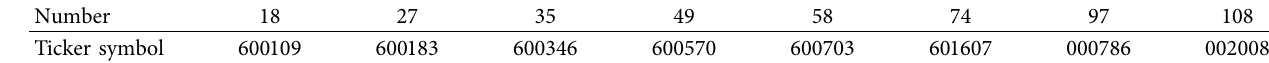
Table 2: List of some of the ticker symbols.